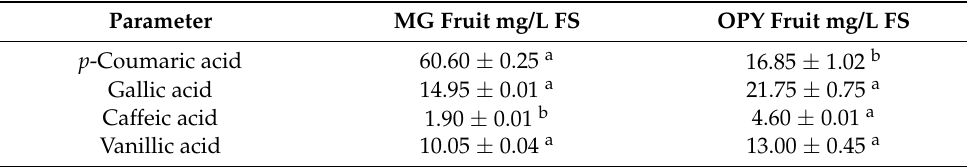
Table 2. Phenolic acids’ composition of Myrtillocactus geomettizans fruit (MG) and Opuntia ficus-indica yellow fruit (OPY) detected by